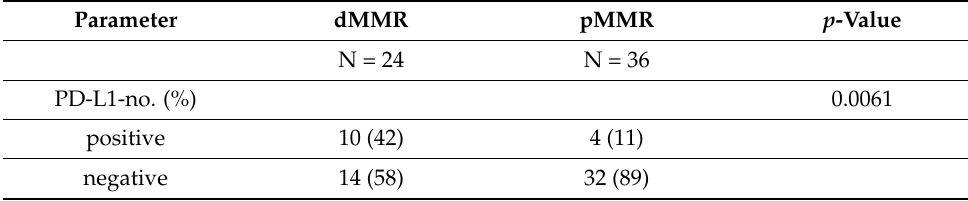
Table 3. Relationship between status of MMR and PD-L1